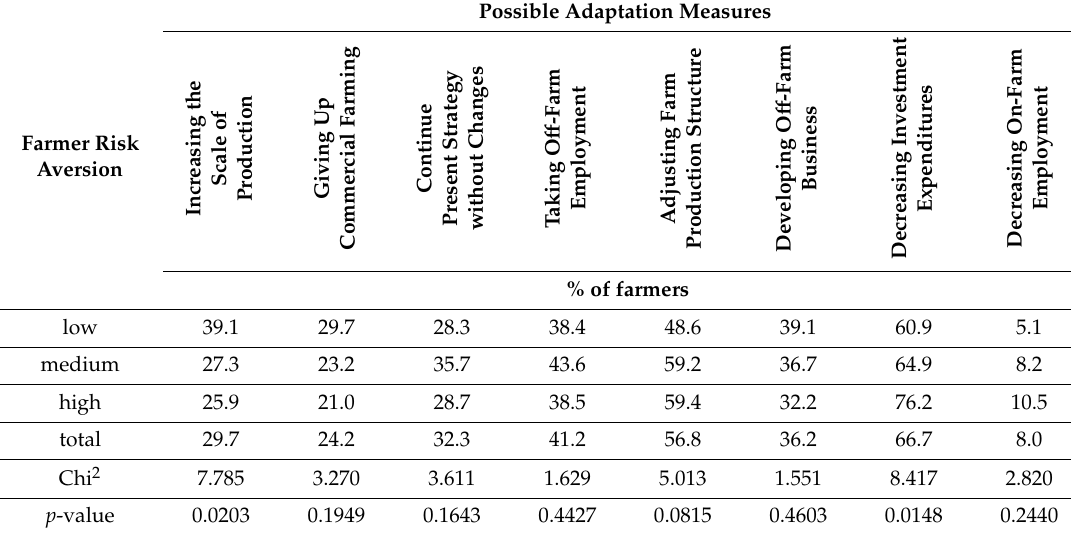
Table 8. Share of farmers declaring the implementation of the indicated adjustment measures in the event of a decrease in agricultural income by over